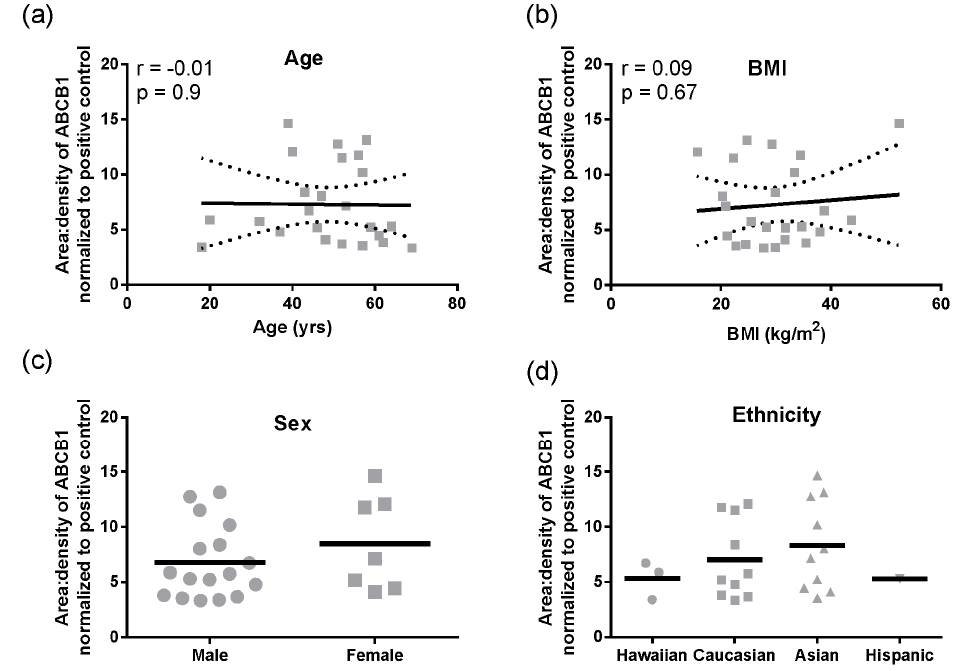
Figure 2: The protein expression of ABCB1 in a cohort of 24 liver lysates. The ABCB1 protein was detected by Western blotting and normalized to the ABCB1 levels detected in a pooled S9 liver sample (Xenotech, n = 200 individuals); ( a ) correlation between age and ABCB1 protein expression with dotted lines 95% confidence intervals; ( b ) Expression of ABCB1 protein compared with BMI; ( c ) The expression of ABCB1 proteins compared to sex; ( d ) Differences between ethnicity and ABCB1 protein expression.